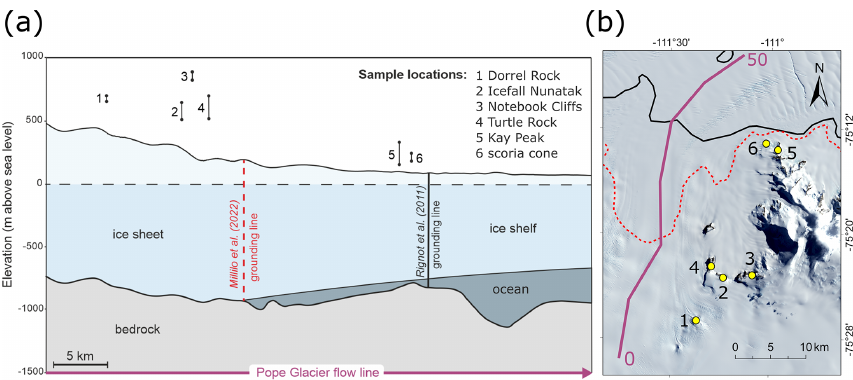
Figure 2. Relationship between nunatak elevation, bedrock and ice sheet topography. (a) Cross-section transects showing modern ice surface elevation data (line above sea level) from REMA (Howat et al., 2019) and bedrock topography (line below sea level) from BedMachine (Morlighem et al., 2020). Note that the glacier flowline profile (solid purple line in panel b ) is > 10km from the sample sites; elevation range markers on the cross-section represent the highest- and lowest-elevation sample at each site (ma.s.l.) (Johnson et al., 2020) and are displayed at points approximately adjacent to flowline on the right-hand panel. (b) Landsat-8 true colour composite (432) image showing location of Pope Glacier flowline with distance downstream from arbitrary starting position. Profile is displayed in the cross-section in panel (a) . Elevation range markers on the cross-section (a) are displayed as yellow dots approximately adjacent to flowline in (b) . Landsat-8 image courtesy of the U.S. Geological Survey; https://doi.org/10.5066/P9OGBGM6 (EROS Center, 2020).